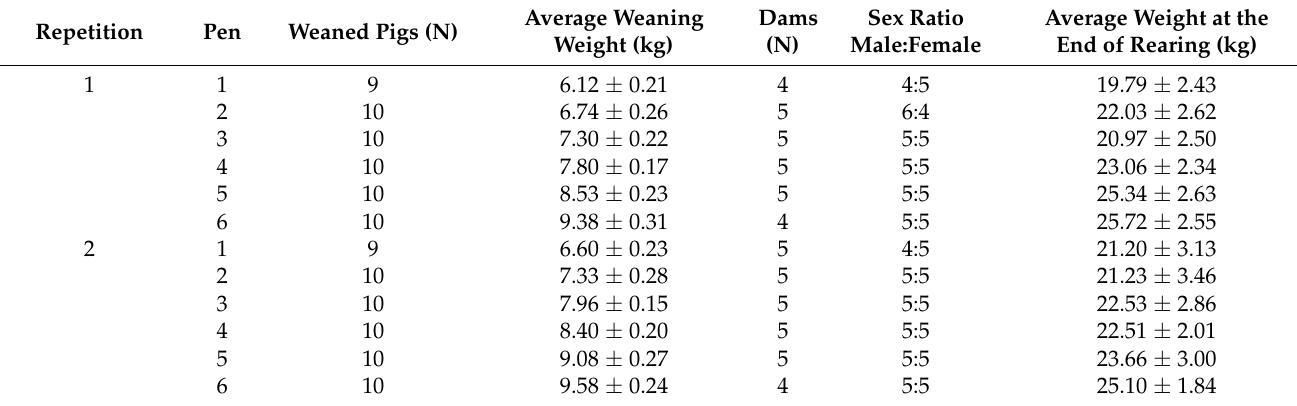
Table 1. Number of pigs, mean weaning and rearing weight ± SD, number of dams and sex ratio per rearing pen.